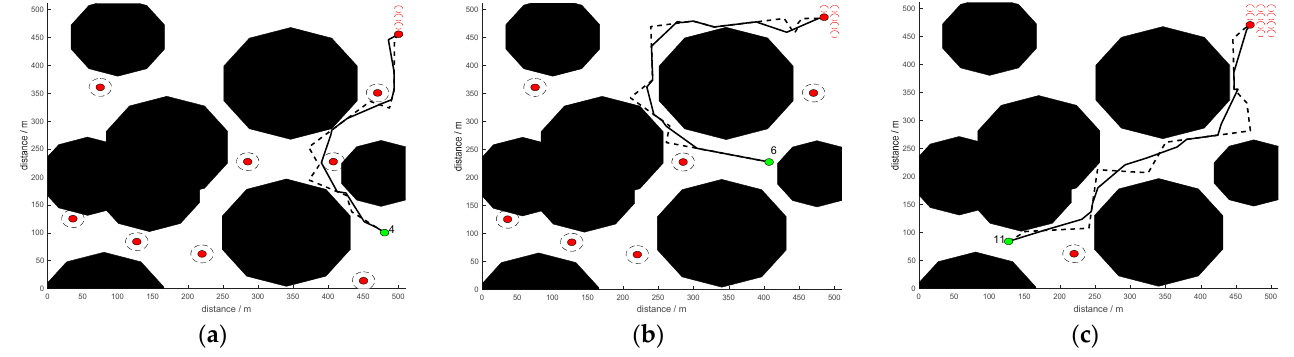
Figure 16. Optimization of different vehicle path results with dual RRT optimization under Map No. 1. ( a – c ) represent the optimization results for vehicle No. 4, vehicle No. 6, and vehicle No. 11, respectively.